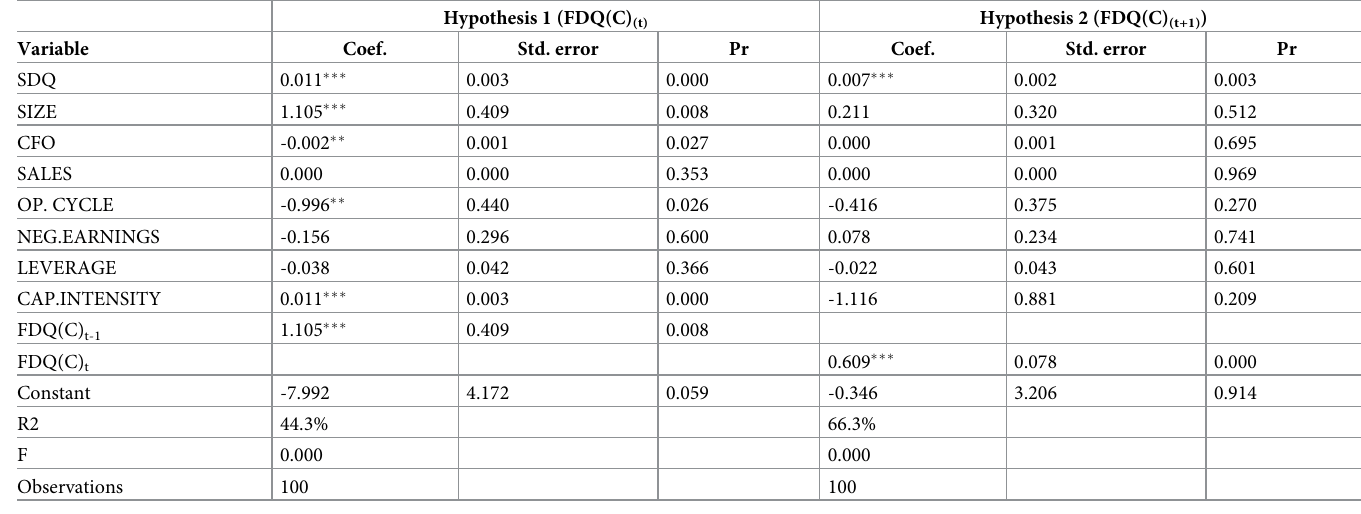
Table 5. Relationship between financial disclosure quality (computed as per Chen et al. [51]) and sustainability disclosure quality. Hypothesis 1 (FDQ(C)